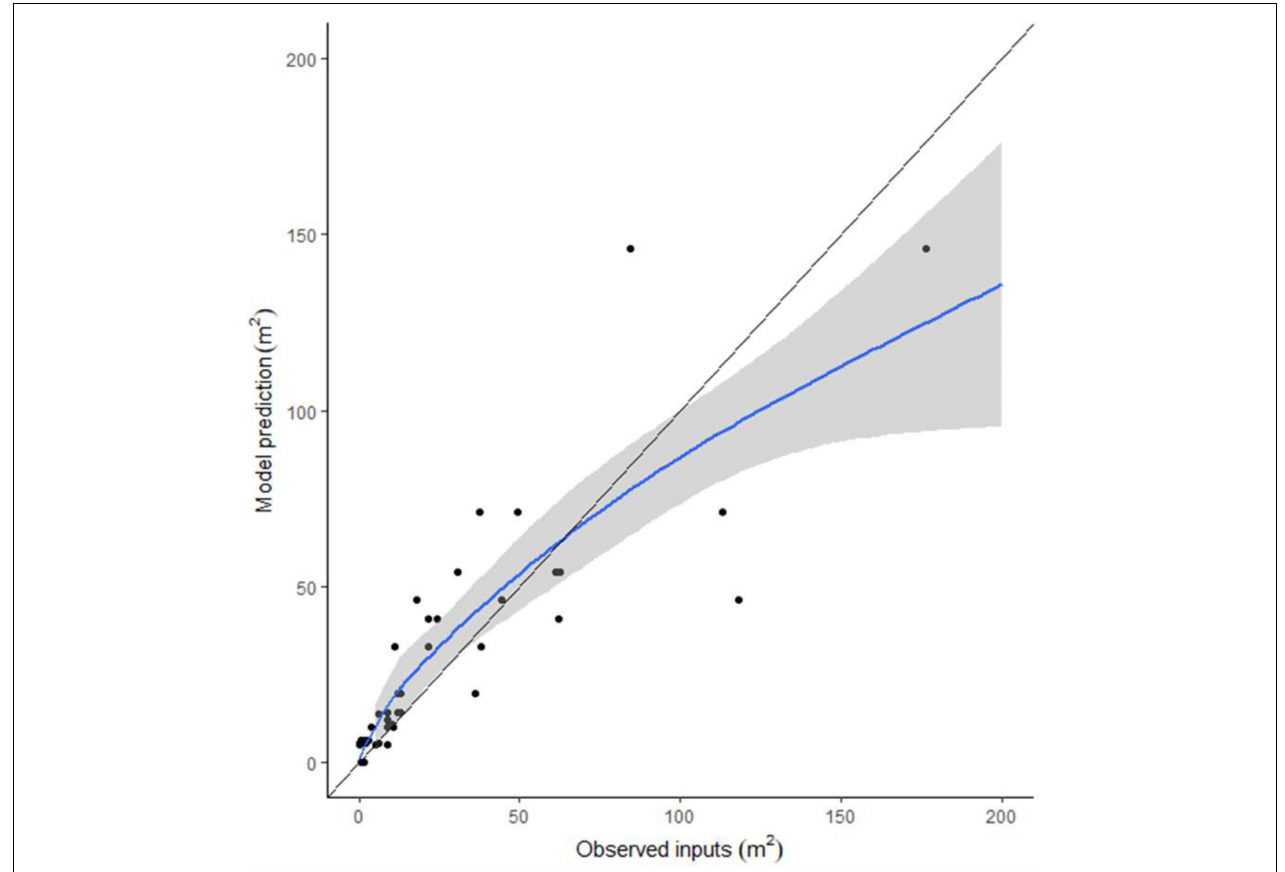
FIGURE 3 | Relationship between observed pellet inputs to the beaches of Santos Bay (particles m 2 · d - 1 ) and predicted pellet inputs from the best performing model that incorporated the factors; PTM, rainfall and beach zone. Shading is the smooth term of the fitted model and the dashed line represents a 1:1 ratio between observed and predicted